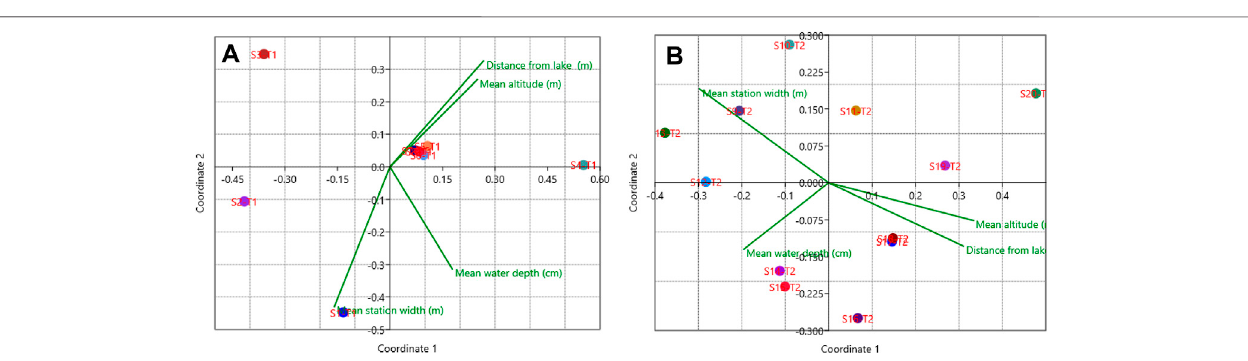
FIGURE 6 | Non-metric multidimensional scaling (NMDS) based on Bray-Curtis Similarity (species abundance from each station and environmental variables; (A) – T1 section; (B) – T2 section).